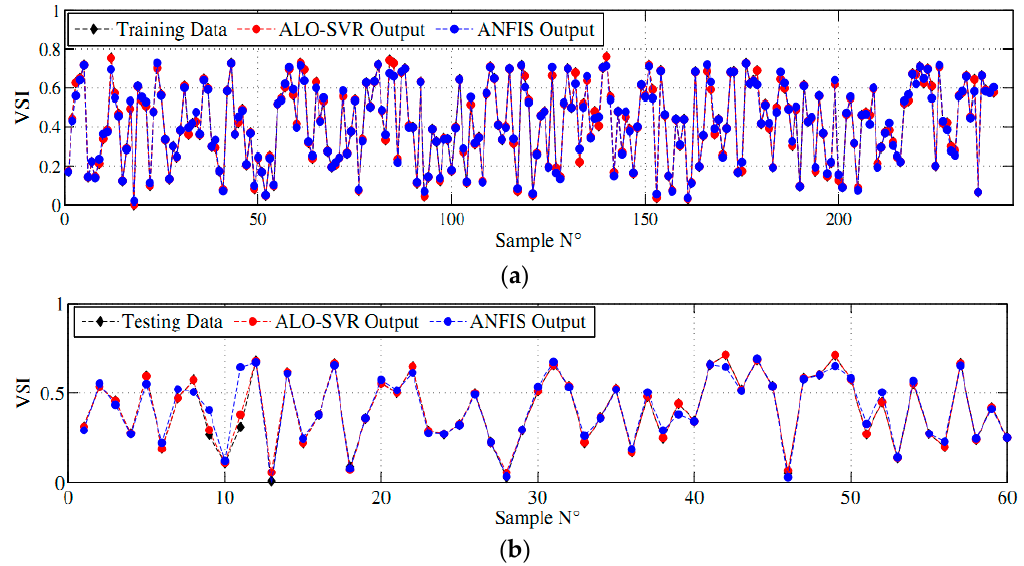
Figure 3. Comparisons between the actual and predicted values of VSI of IEEE 30-bus in ( a ) Training process; ( b ) Testing process.